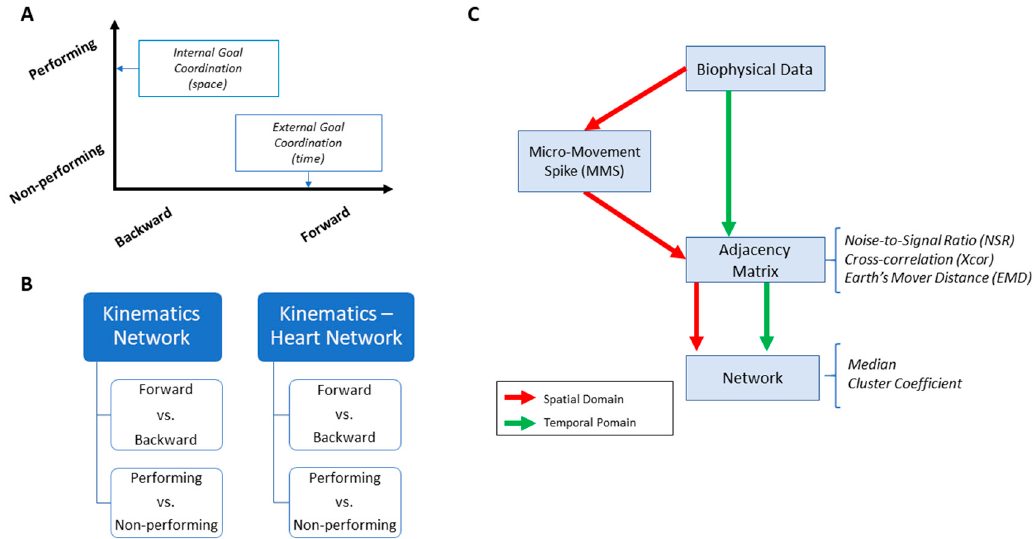
Figure 3. Overview of analytics pipeline. ( A ) Behavioral assay to quantify ranges of motor intent along two axes to highlight externally and internally defined goals. Along the former, motions are classified across time based on the end-e ff ector’s movement, ranging from backward–spontaneous (lower motor intent) to forward–deliberate (higher motor intent) motions. Along the other axis, motions are classified across locations of the body, based on the proximity to the end-e ff ector, from non-performing side of the body parts (lower motor intent) to the performing side including the end-e ff ector (higher motor intent). Note, the two axes are not necessarily orthogonal as the schematics imply. ( B ) Two types of network analyses were made. Within the kinematics network, kinematics data served to compare patterns of variability from movement segments of higher level of intent (deliberately aimed at the goal) and movement segments with lower level of intent (spontaneous retractions of the hand to rest, without instructions), including as well comparison of patterns from the performing and non-performing parts of the body. Within the kinematics-heart network, a similar comparison was made, with a layer of autonomic function added, using signals from the EKG sensors. ( C ) For the spatial domain of connectivity analysis, raw biophysical data (biorhythms) co-registered from multiple layers of the peripheral and autonomic nervous systems were converted to MMS and used to compute pairwise similarity / synchronicity metrics to build adjacency matrices to represent weighted / undirected graphs. For the temporal domain, the raw biophysical data were directly used to build adjacency matrices. For both domains, with the obtained adjacency matrices, network connectivity analyses combined with non-linear dynamical systems approaches were used to identify self-emerging kinematic synergies and various indexes to enable objective quantification of the embodied cognition